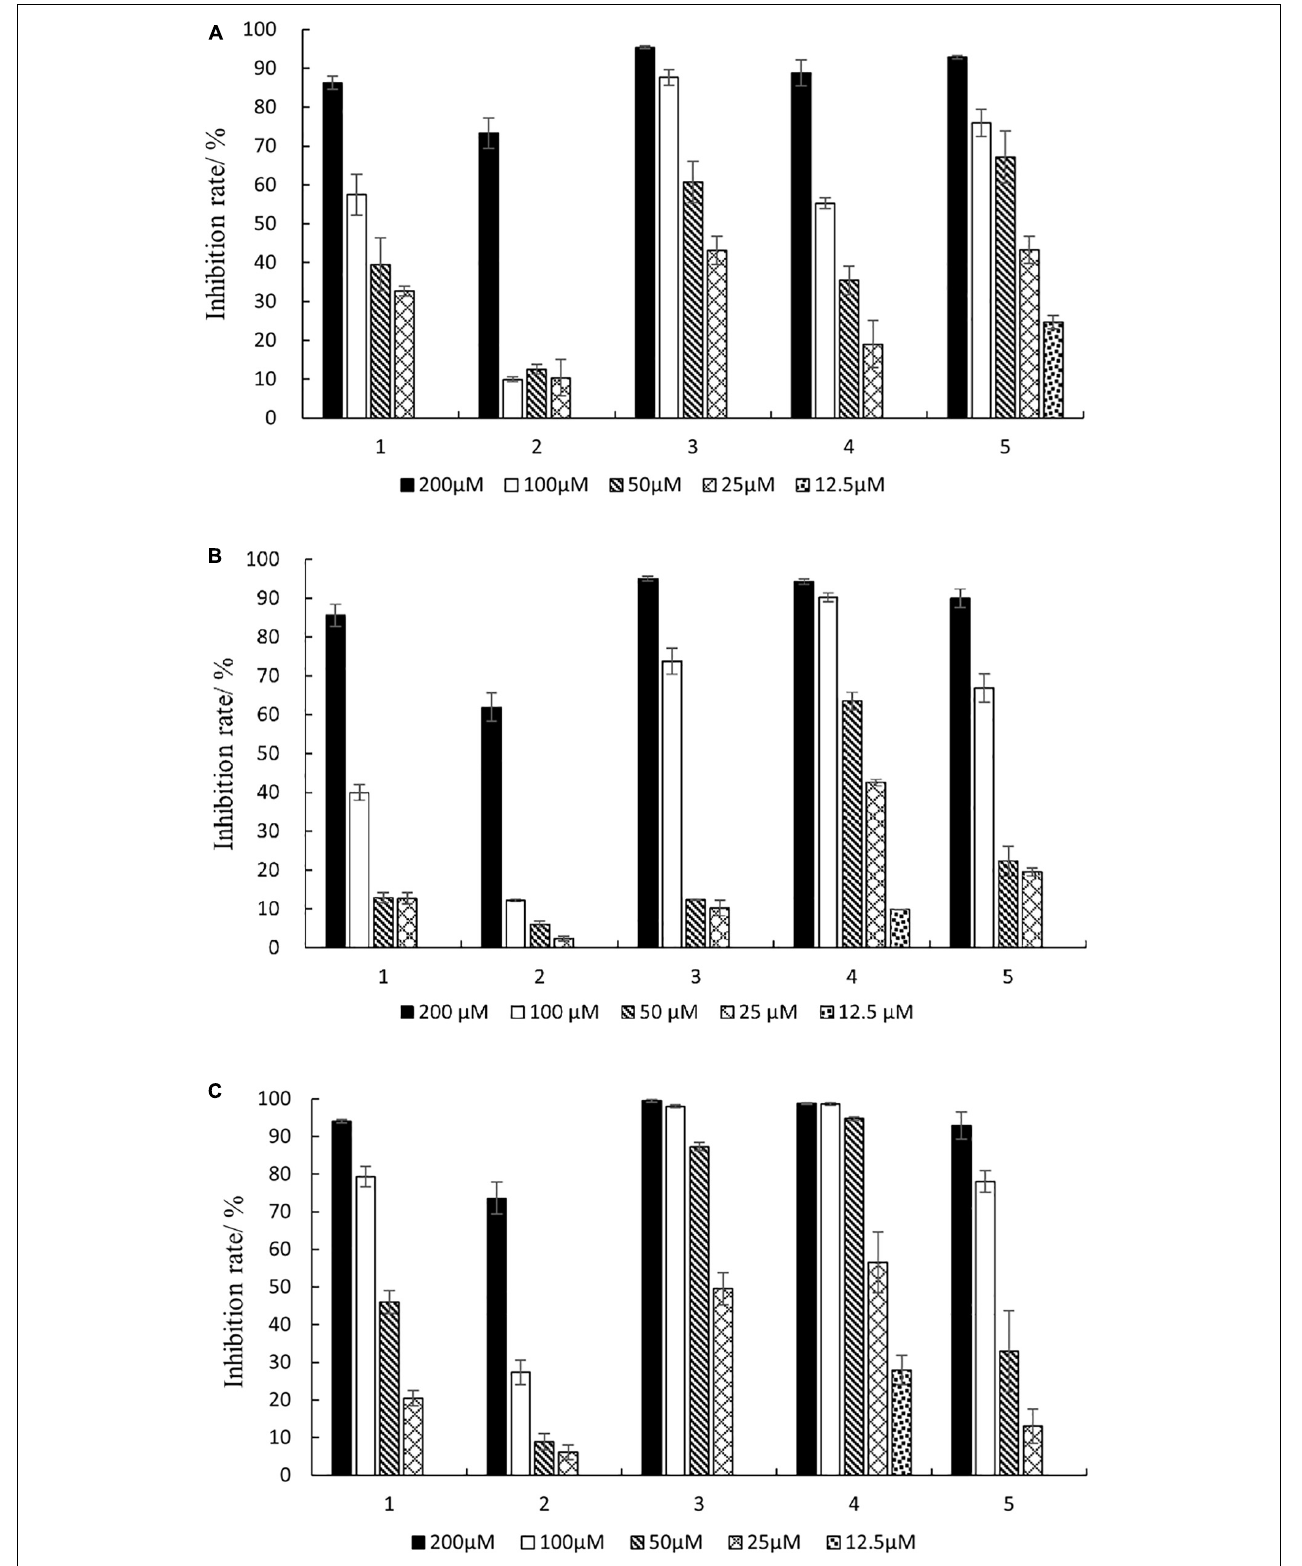
FIGURE 6 | Inhibition rates against three cancer cells of different concentrations of compounds 1–5 . (A) HepG2; (B) A549; (C) MDA-MB-231.